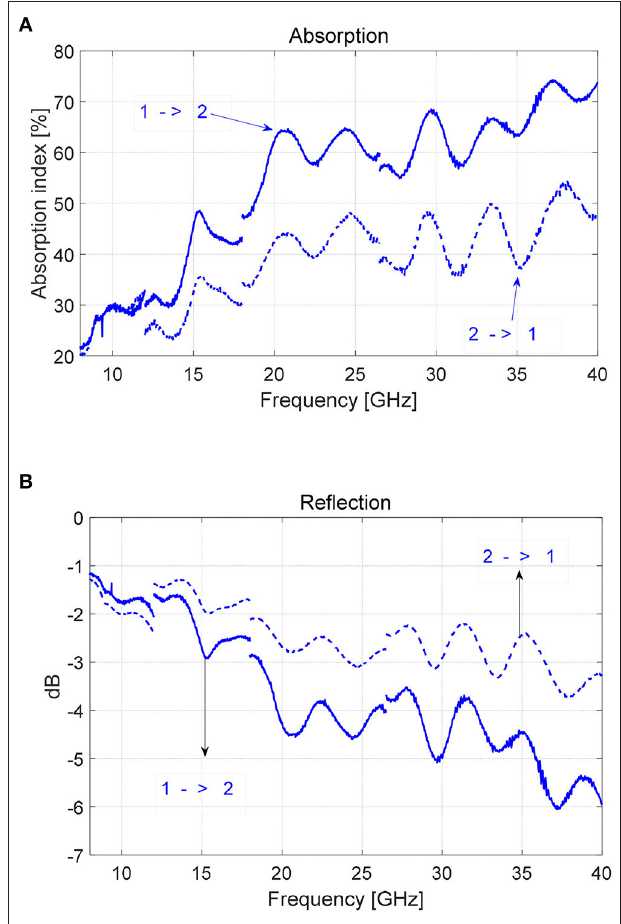
FIGURE 4 | Absorption (A) and reflection (B) measurements of CNT-polymer gradient